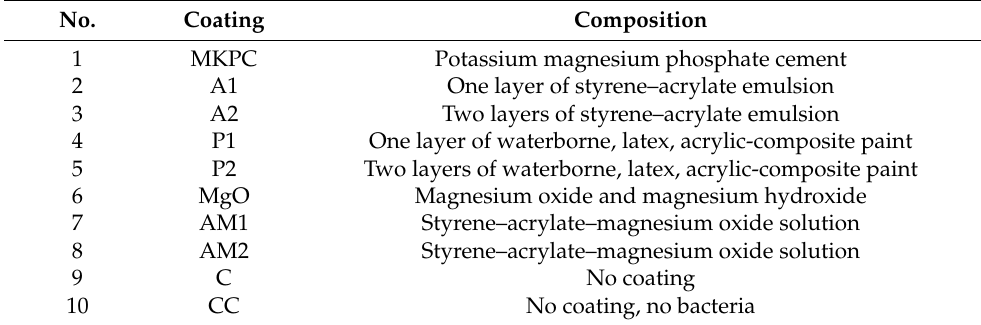
Table 1. Coatings for the expanded clay used in this study.